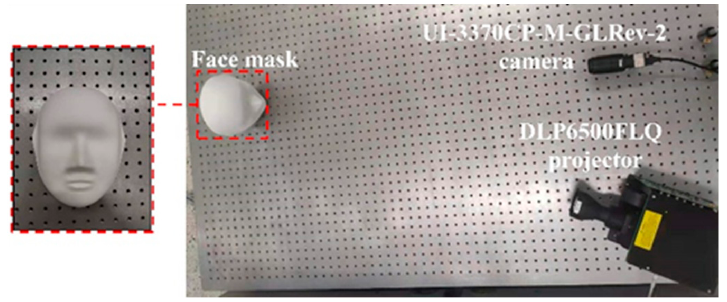
Figure 6. Experimental setup.